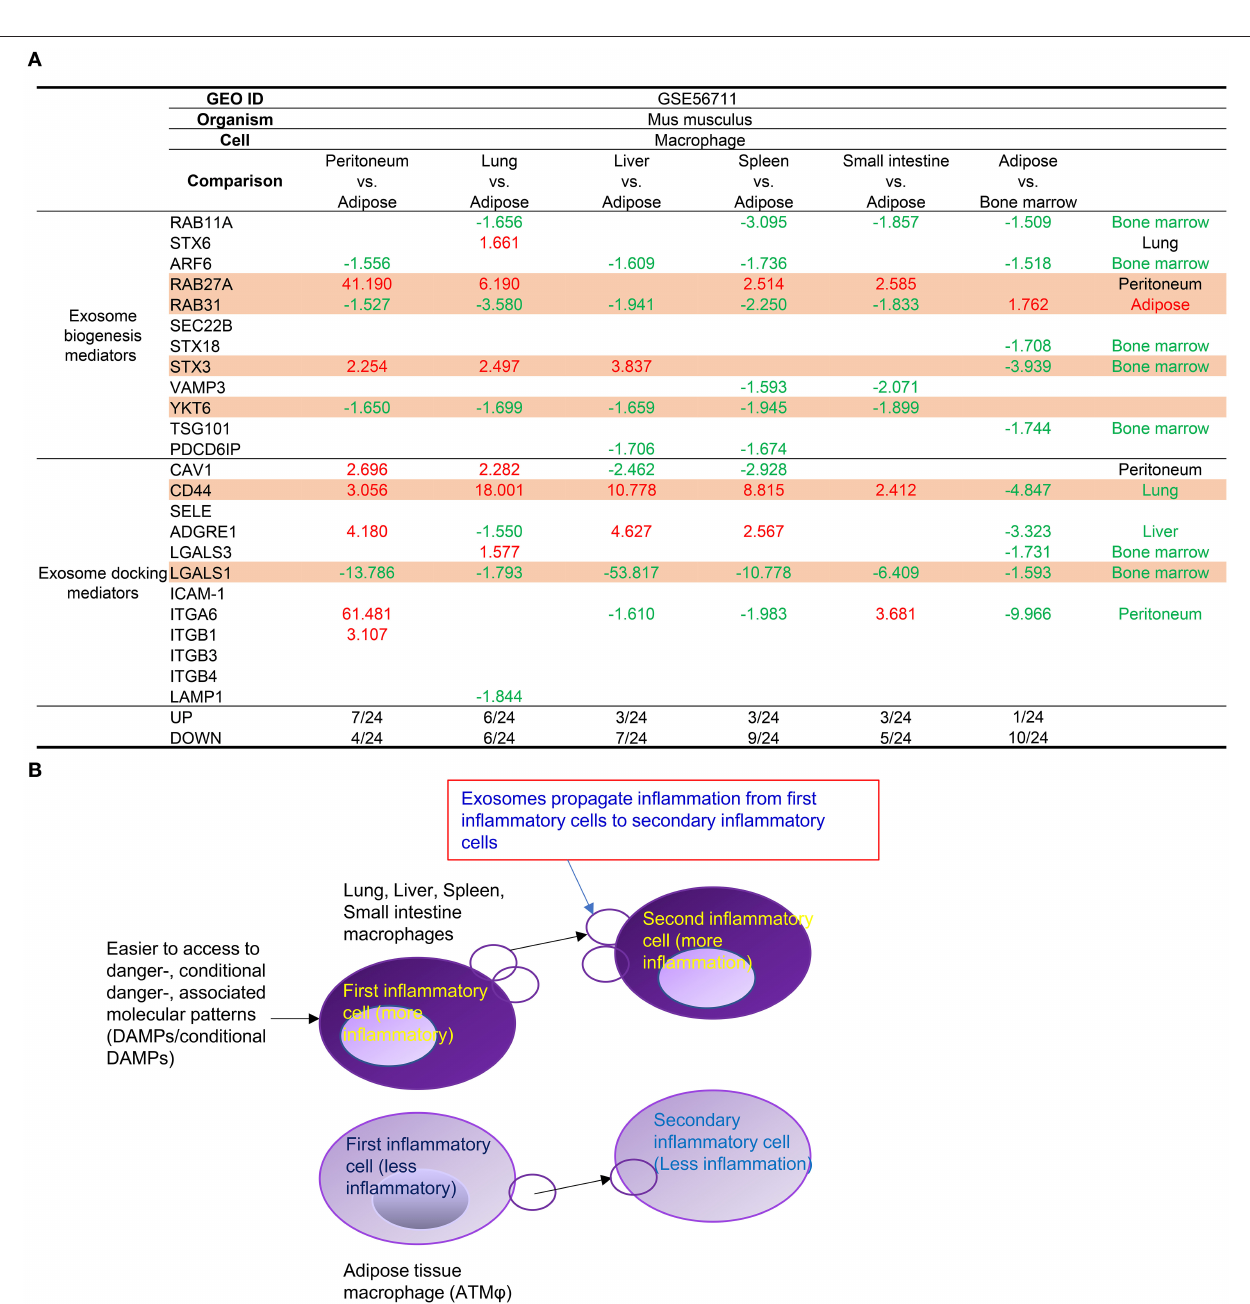
FIGURE 4 | (A) Mechanism IV. Tissue macrophages (M ϕ ) have differences in the expression of several mediators for exosome biogenesis and docking. First, M ϕ from peritoneum, lung, liver (STX3), spleen, and small intestine prefer to use RAB27A and STX3 than RAB31 and YKT6 in mediating exosome biogenesis and CD44 for docking in comparison to lean ATM ϕ . In addition, M ϕ from lung also upregulates STX6 (biogenesis), CAV1, and LGALS3 (docking) comparing to lean ATM ϕ . Moreover, M ϕ from peritoneum and intestine upregulate ITGA6 for docking in comparison to lean ATM ϕ . (B) M ϕ from peritoneum, lung, liver (STX3), spleen, and small intestine prefer to use RAB27A and STX3 rather than RAB31 and YKT6 in mediating exosome biogenesis and CD44 for docking, presumably to make exosomes more effective in propagating inflammation than adipose tissue macrophages. As cell-cell communication vehicles, exosomes propagate inflammation from first inflammatory cells to secondary inflammatory cells [see also Figure 5 of our previous report for more evidence and the experimental data of others (PMID: 27842563)].